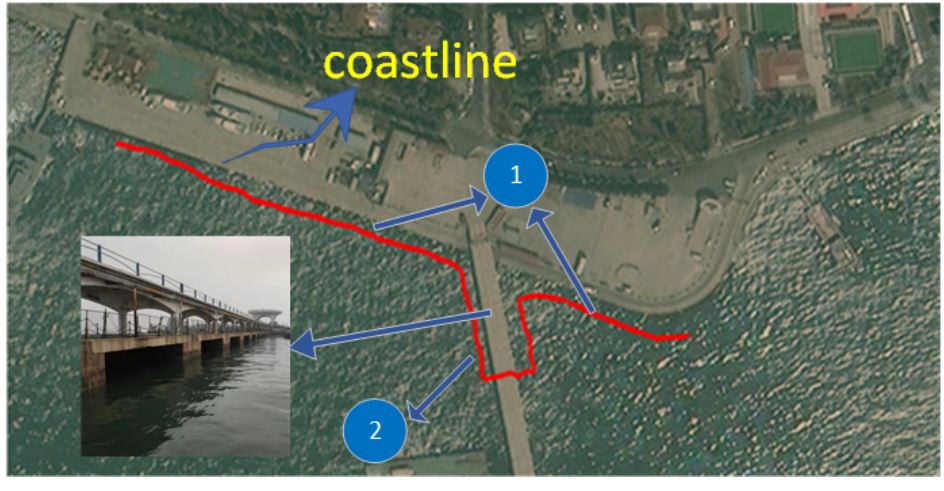
Figure 7. AUV trajectory.